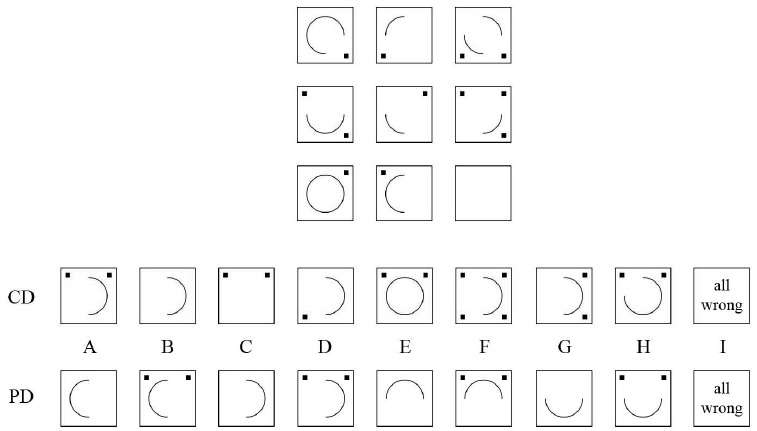
Figure 3. Item stem with conceptual distractors (CD) and perceptual distractors (PD).